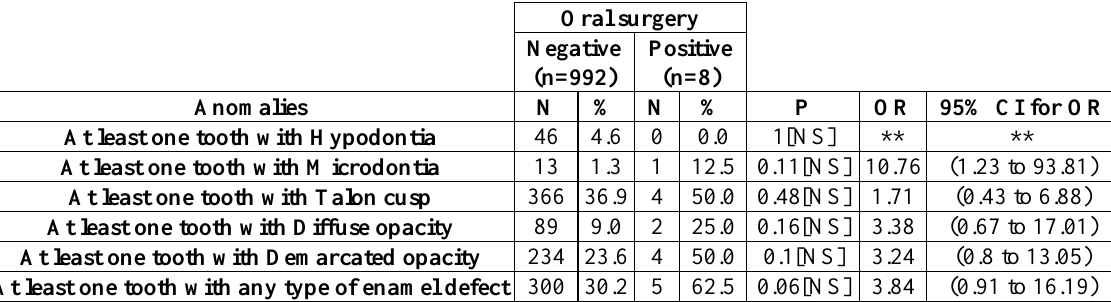
Table 5: The relationship between previous oral surgery and dental anomalies Oral surgery